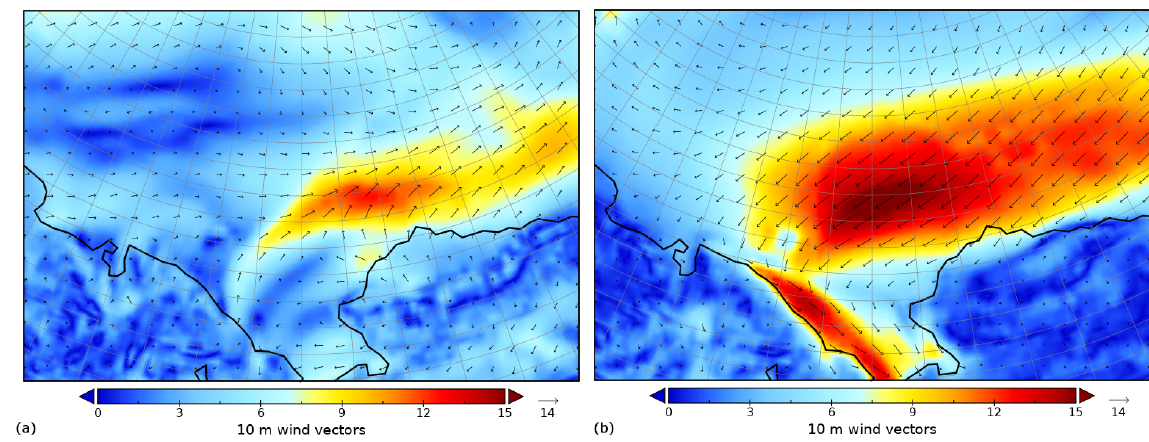
Figure 6. ERA5 10m wind speed (ms − 1 ) and vectors to depict the forcing for southwesterly on-ice winds on 15 November 2018, 00:00 (a) , and northeasterly off-ice winds on 21 November 2018, 21:00 (b) .